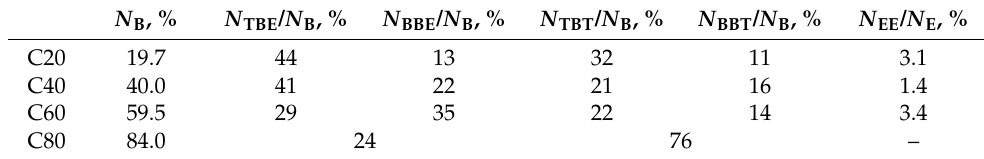
Table 3. The composition of the macromolecules in copolyesters C20–C60.